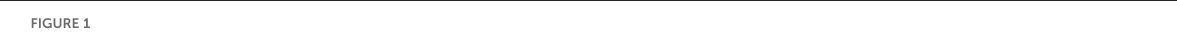
FIGURE1 = 5; and Ss, n = 5. (B) The abundance of fecal bacteria in Hl inhabits either the Asian tropical rainforest area ( n = 3) or the conservation area ( n = 3). (C) Microbial community composition at the phylum taxa level. The top six dominant phyla are indicated in all samples. Alpha-diversity analysis, by (D) Shannon and (E) Chao1 indexes, of the fecal bacterial community structure of cohorts housed in the Asian tropical rainforest area. Hl, n = 3; Pp, n = 5; and Ss, n =